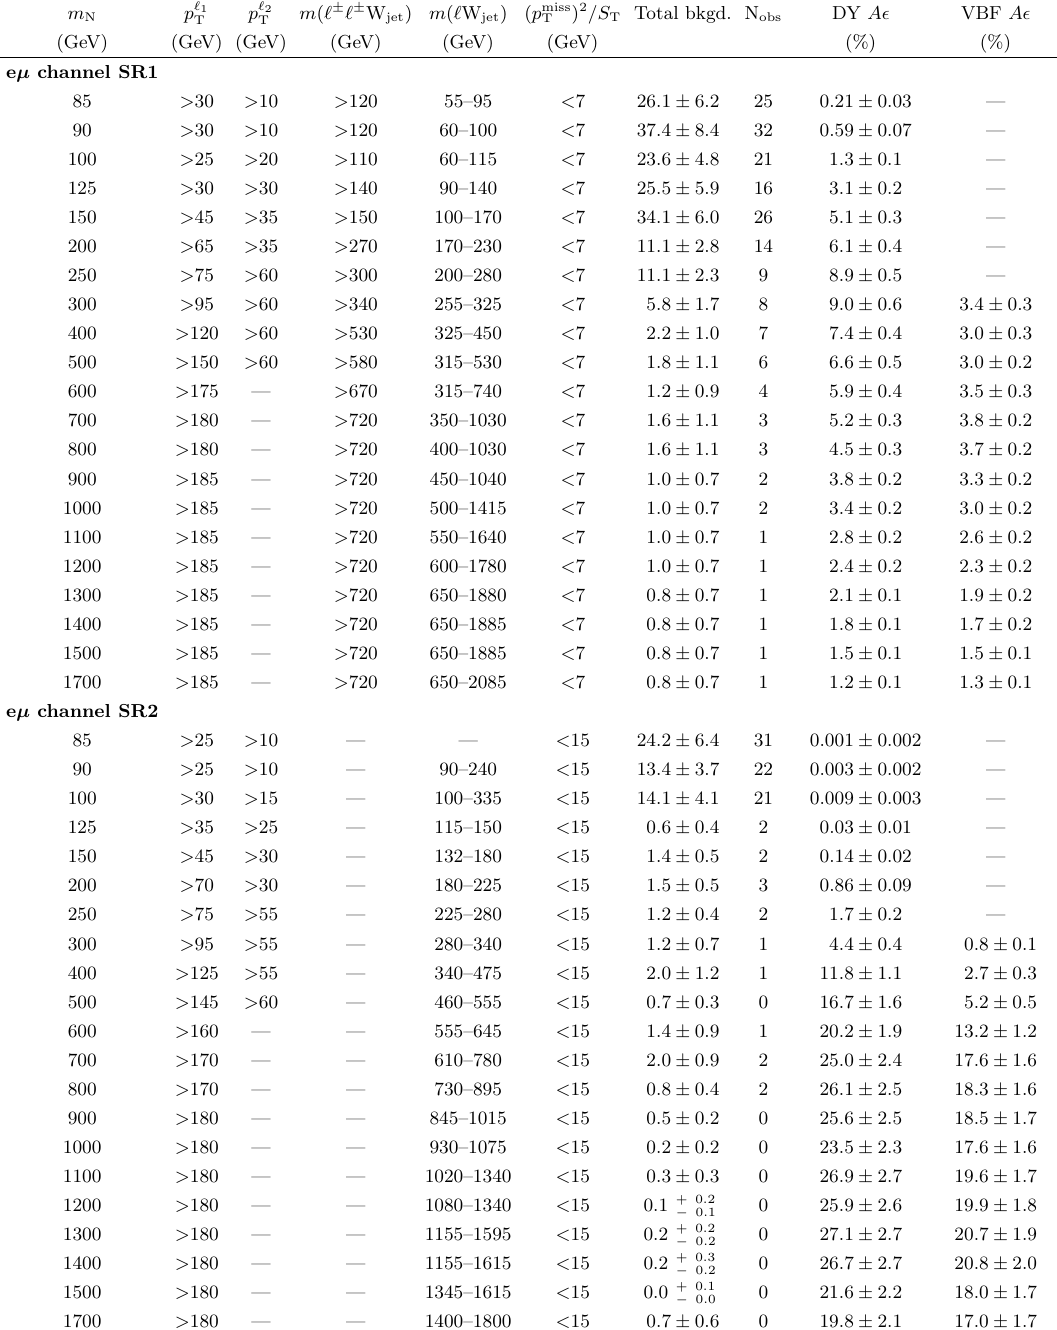
Table 10 . Selection requirements on discriminating variables determined by the optimization for each Majorana neutrino mass point in the e (cid:22) channel high-mass SRs. Columns 7 and 8 show the total background yields (Total bkgd.) and the number of observed data (N obs ), respectively. The last columns show the overall signal acceptance for the DY and VBF channels. The quoted uncertainties include both the statistical and systematic contributions. The dash indicates that no selection requirement is made.